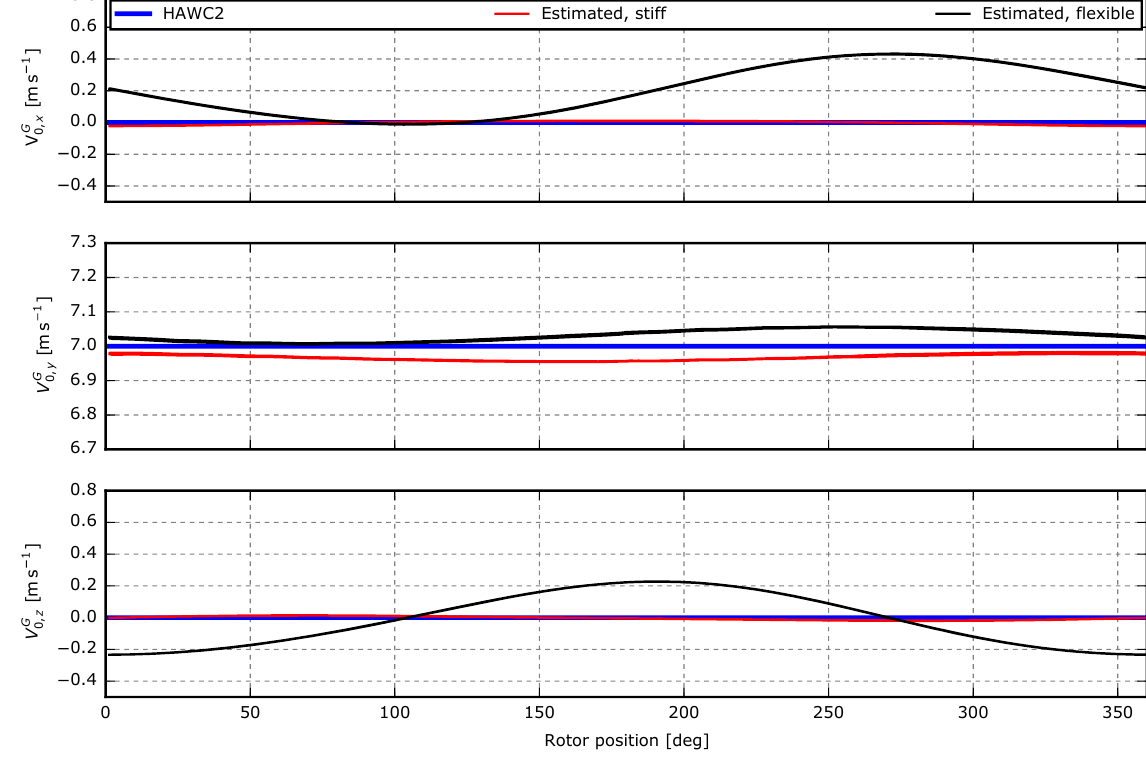
Figure 10. HAWC2 results including the free wind speed estimated in 13ms − 1 steady uniform inflow for stiff (Case 1) and flexible (Case 2) structural